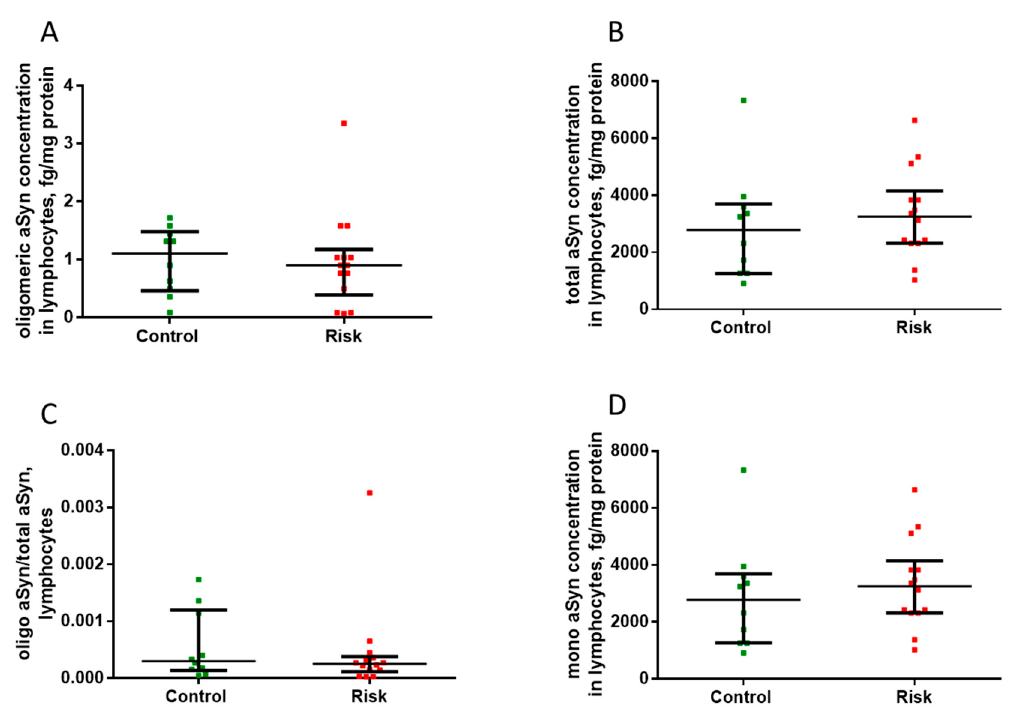
Figure 11. Concentrations of total α -synuclein ( A ), monomeric α -synuclein ( B ), and oligomeric α -synuclein ( C ), as well as the ratio of oligomeric α -synuclein to total α -synuclein ( D ) in lymphocytes in the patients at risk and in the control group. Data presented as a median with an interquartile range and min–max values.